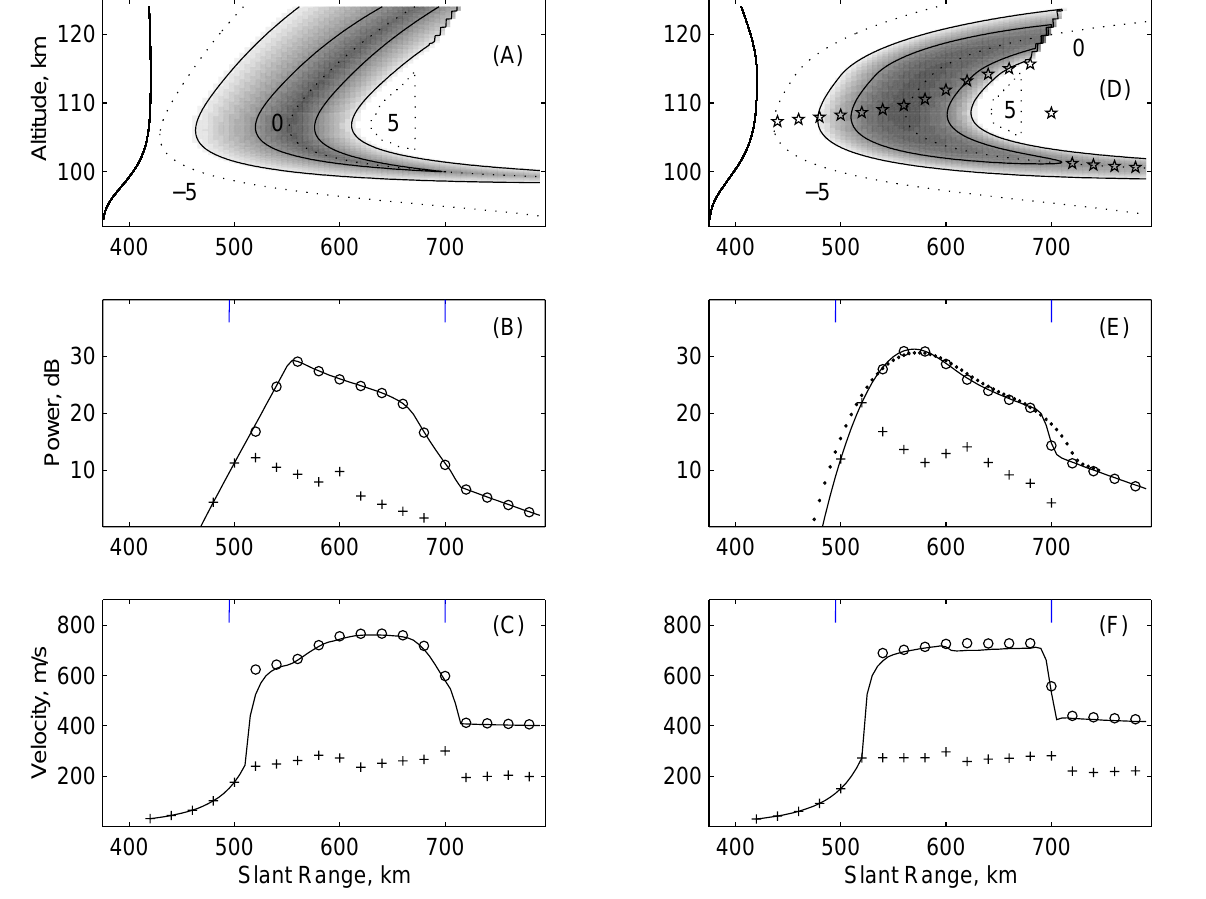
Fig. 7. (a) and (d) : The model altitude-range distributions of the relative radar volume cross section represented by 20-dB step isolines and by darkness of the tone for two N(h) -profiles (shown at the left-hand portions of the panels) with the electron density at a maximum of 0.65 · 10 11 m − 3 . The dots are the lines of zero and +/–5 ◦ aspect angles. (b) and (e) : The height-integrated power range profiles (solid lines). The small dots on panel (e) illustrate the profile that would be observed in a case of a 45-km radar range resolution. (c) and (f) : The predicted Doppler velocity (solid lines). The open-circles on panels (b-f) are the power-weighted height-integrated power and velocity of the in-cone irregularity component (off-orthogonal angle magnitudes are less than 1.6 ◦ ), while crosses are the power and the velocity for the out-of-cone irregularity component (off-orthogonal angle magnitudes are more than 1.6 ◦ ). The stars on panel (d) illustrate the range profile of the mean backscatter altitude (for more details see text in Sect. 4). The vertical bars in the upper parts of panels (b), (c), (e), and (f) represent the range interval of the high-velocity echo observations (Fig.